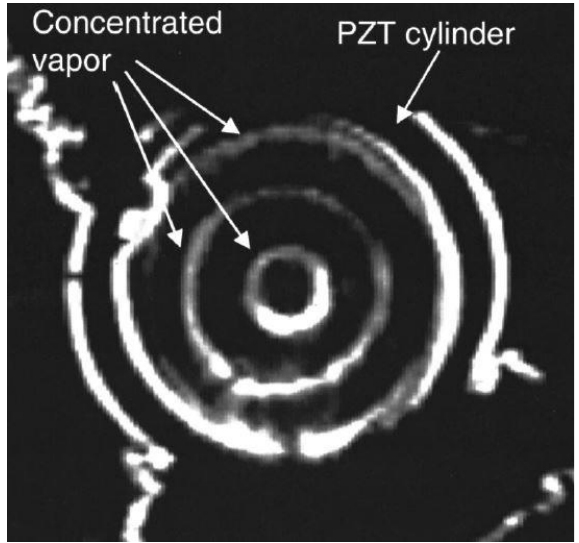
Figure 3. Effective concentration of water vapor at the nodal circles inside the PZT cylindrical transducer with a cut along the length [45].